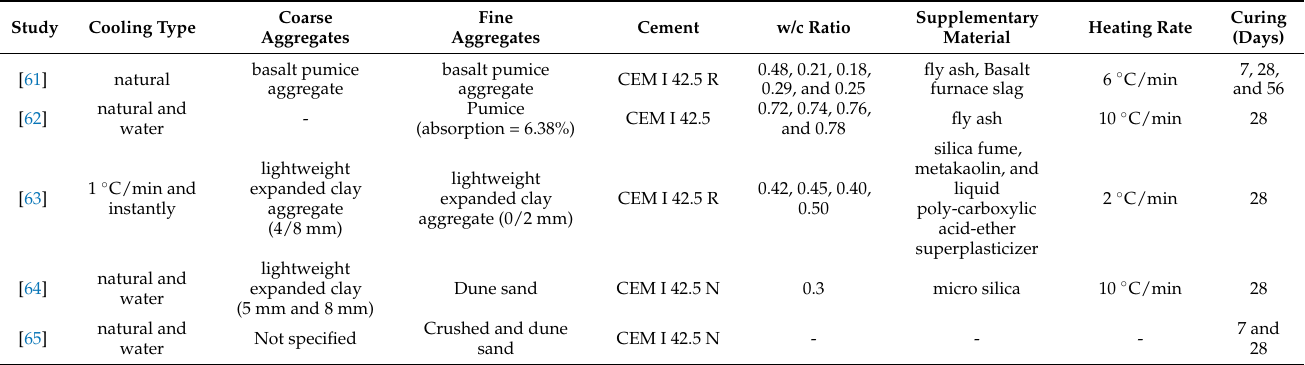
Table 2. Important parameters of different studies on LWC [61–65].